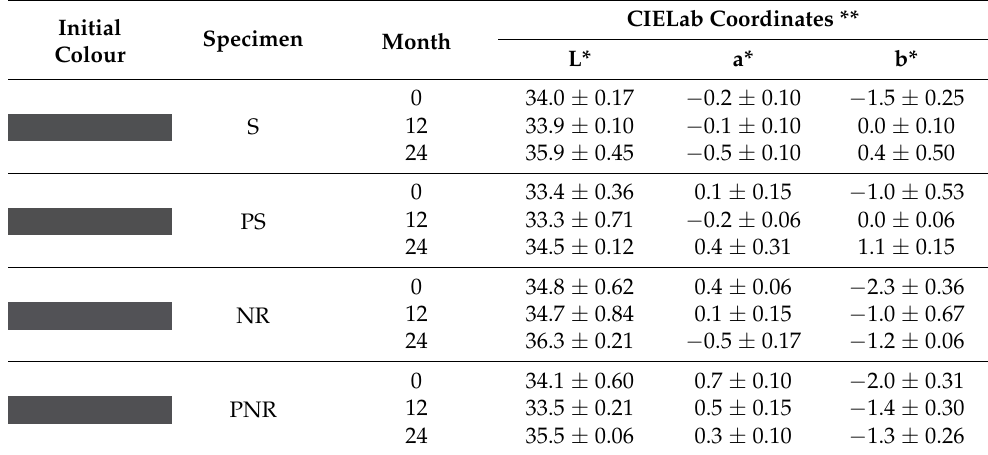
Table 2. CIELab colour coordinates.